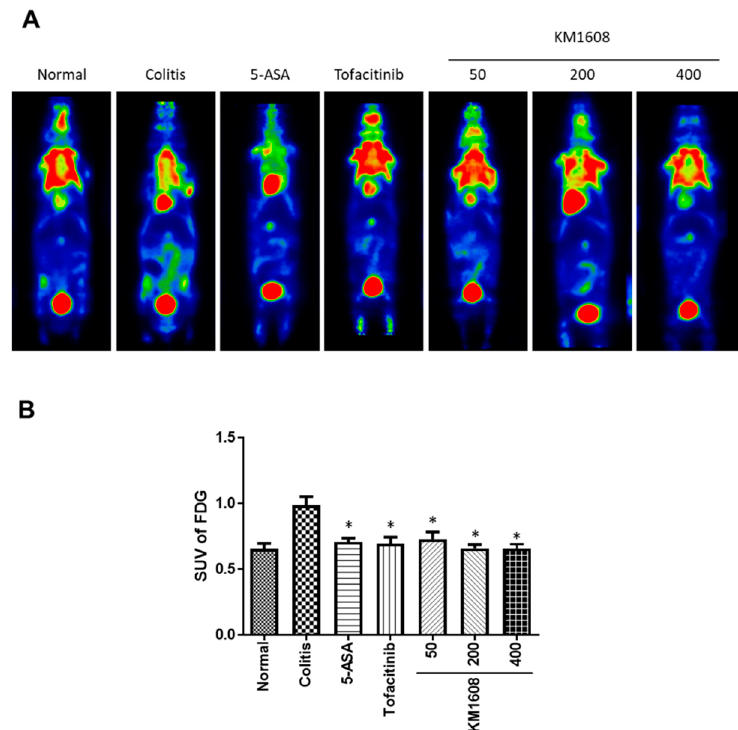
Figure 1. 2-deoxy-2-[18F]fluoro-D-glucose (FDG)–positron emission tomography (PET) imaging in dextran sodium sulfate (DSS)-induced colitis. Colitis was induced in C57BL / 6 mice by the addition of 1.5% DSS in drinking water for 7 days. Animals were treated with KM1608 (50, 200, and 400 mg / kg), 5-ASA (200 mg / kg), and tofacitinib (10 mg / kg) orally once a day. 5-ASA and tofacitinib were used as reference drugs. PET images were obtained on Day 7 before euthanasia ( A ). FDG uptake in the lower gut area was higher in colitis mice than in normal mice, and the 5-ASA-, tofacitinib-, and KM1608-treated mice showed a lower FDG uptake in the lower gut than the other colitis mice. FDG uptake in the lower gut area was quantified ( B ). Data are presented as the mean ± SEM. n = 8. * p < 0.05 vs. colitis.